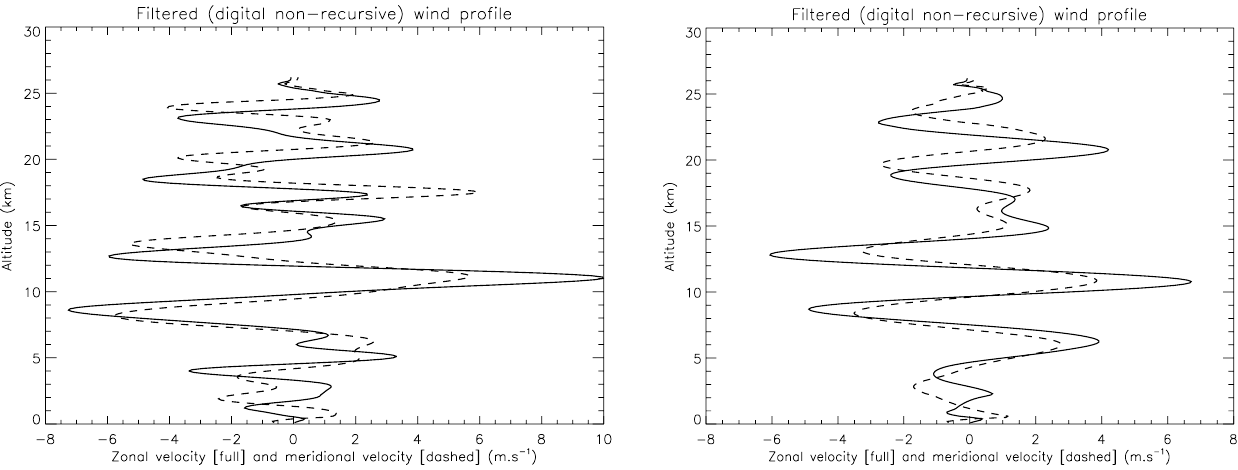
Fig. 3. Case 1: Santo Domingo radiosounding. Vertical profiles of velocity perturbations (ms − 1 ). Full line: zonal wind, dashed line: meridional wind. Left: Non-recursive digital filter with wide bandpass window of [1.5,8]km. Right: Non-recursive digital filter with narrower bandpass window of [3,6]km. The choice of this filtering window is based on the Fig. 2 results.